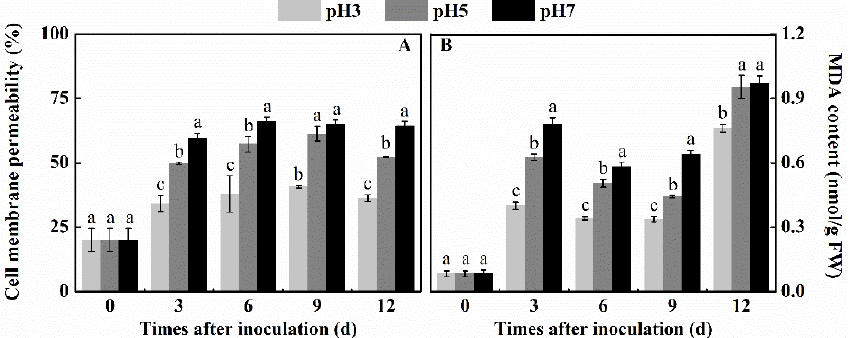
Figure 1. Effect of inoculation of T. roseum at different pH conditions on cell membrane permeability ( A ) and malondialdehyde content ( B ) of colonized apple fruits. Bars indicate standard error (±SE). Different letters indicate statistically significant differences ( p < 0.05) among treatments.